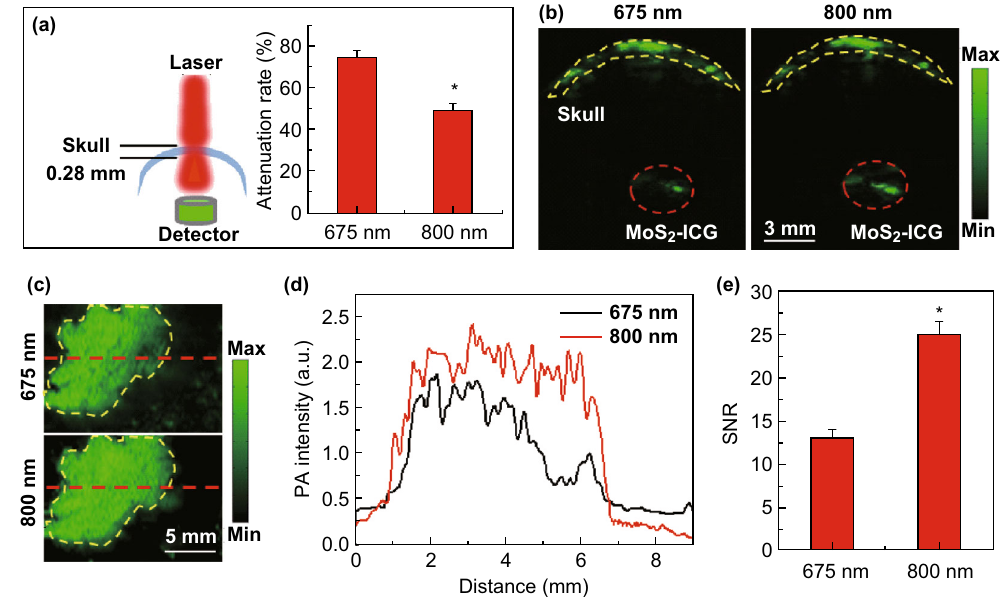
Fig. 3 a Attenuation rate of 675- and 800-nm pulsed laser after penetrating the mouse skull. b Photoacoustic cross-sectional B-scan images of MoS 2 –ICG covered with mouse skull under 675- and 800-nm laser excitation. Yellow dashed line delineates the outline of the skull. Red circle indicates the MoS 2 –ICG sample. c Photoacoustic MAP images of mouse back post-subcutaneous injection of MoS 2 –ICG under 675- and 800-nm laser excitation. The enclosed area by the yellow dashed line indicates the injected region. d Photoacoustic signal intensity plot corresponding to the two red dashed lines in c . e SNR of photoacoustic images under 675- and 800-nm laser excitation in